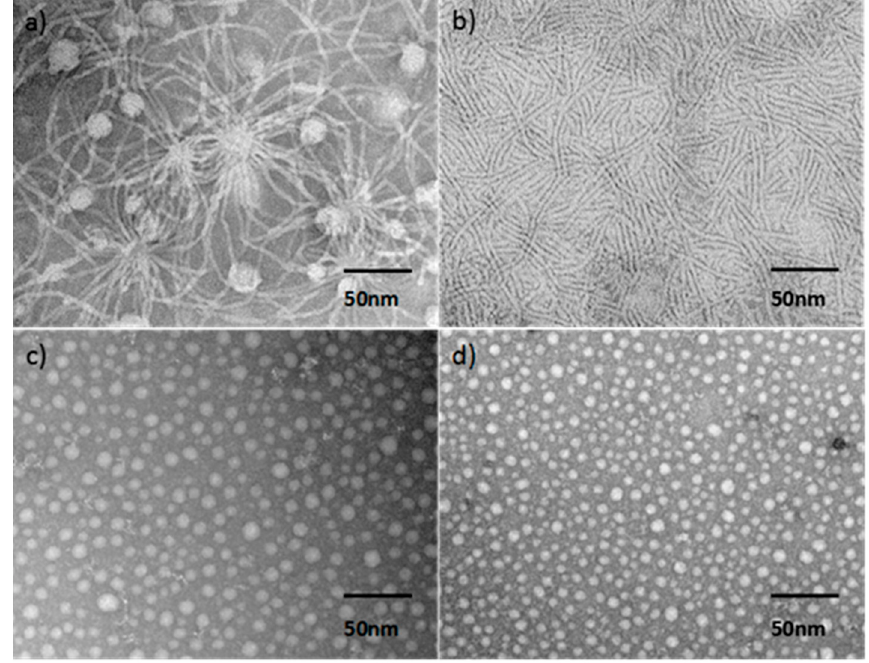
Figure 6. TEM images of ( a ) 1 , ( b ) 2 , ( c ) 3 , and ( d ) 4 , obtained from 0.01 wt % in aqueous solution, samples are negatively stained with uranyl acetate.